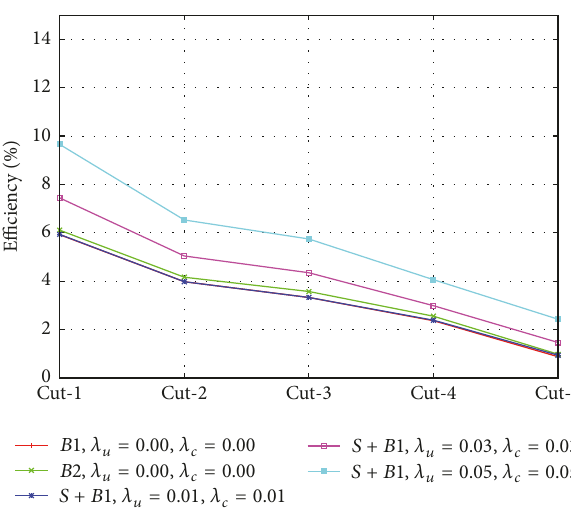
Figure 7: Efficiency plot for the cuts applied at each step for the analysis of signal ( 𝑆 ) + background ( 𝐵1 ) and background ( 𝐵2 ) events. The cut efficiencies are calculated with respect to the preselection cuts for each coupling